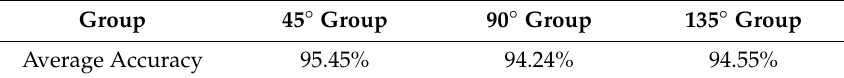
Table 3. Average classification accuracy in three angles for MSOGDF.